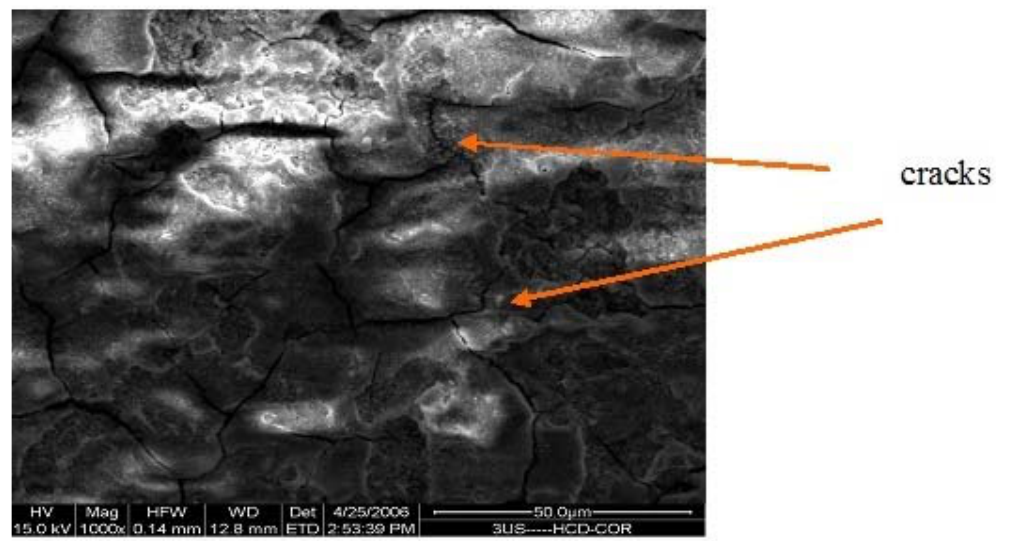
Figure 8. SEM of surface of 3ushcd after polarization test in SBF.